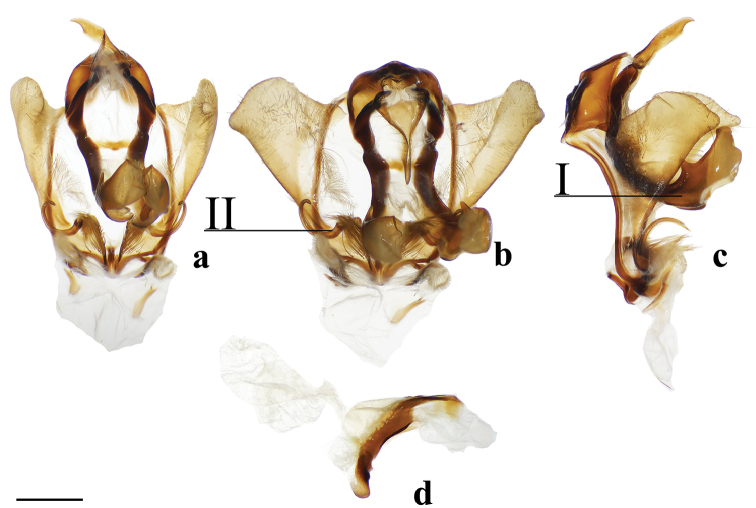
Male genitalia of Lepismallamontagnaniaea ventral with valvae in natural position b ventral with valvae spread c ateral d phallus. Roman numerals refer to characters discussed in the text. Note that uncus is twisted to the left in Fig. 132a. French Guiana, genitalia vial NHMUK 010402310 (NHMUK). Scale bar: 1 mm.